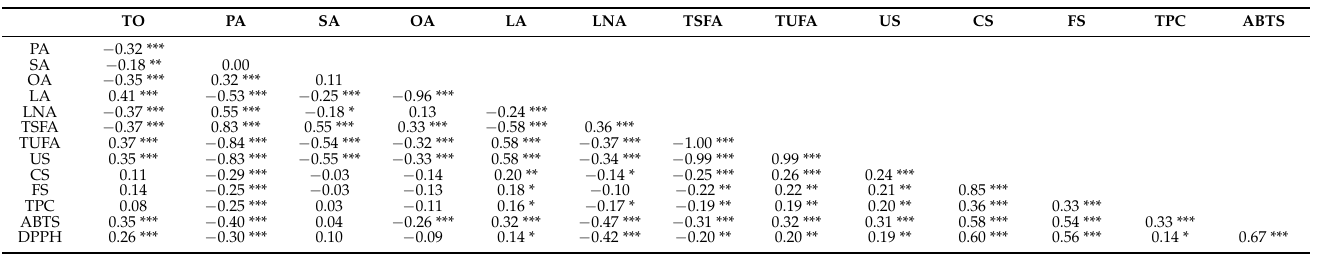
Table 3. Pearson correlation coefficients of total oil content, fatty acid profile, phytochemical content, and antioxidant